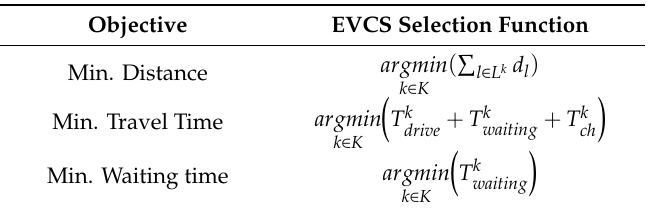
Table 5. Benchmarking